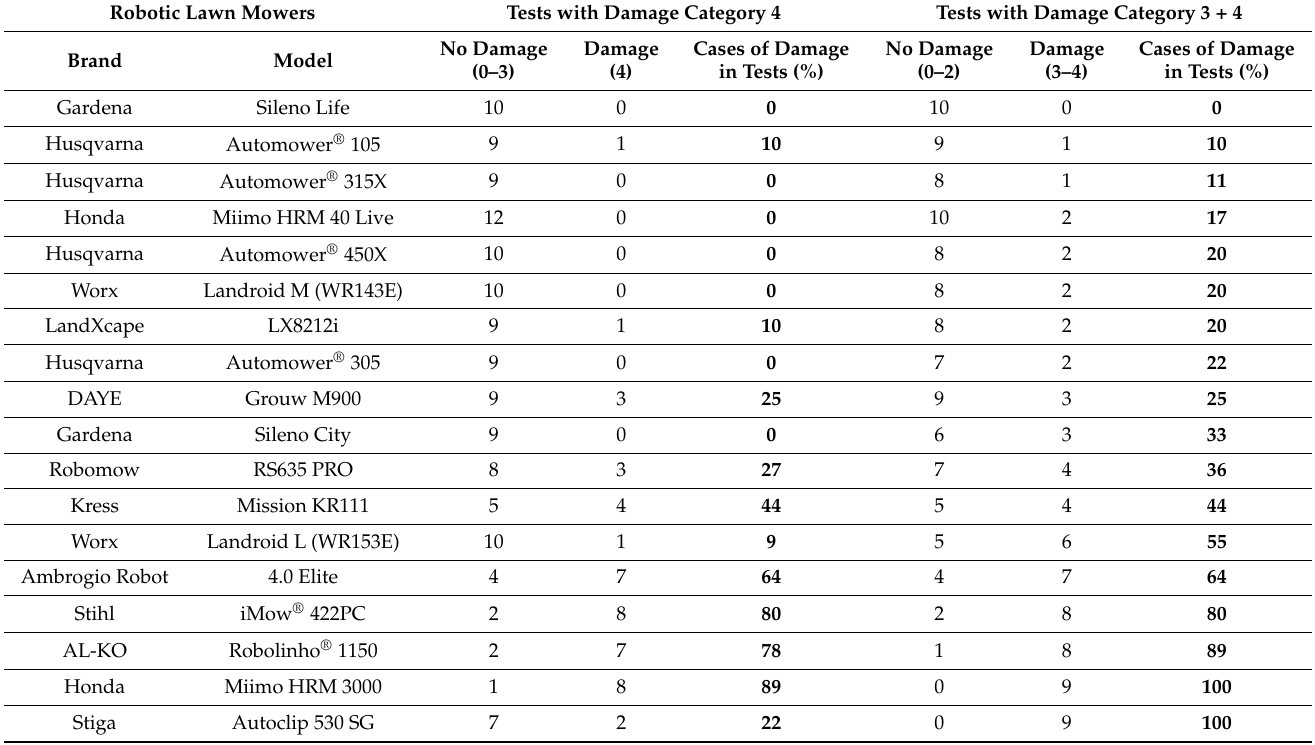
Table 4. The percentage distribution of tests resulting in damage to the hedgehogs, defined either as damage category 4 or damage category 3 + 4. Damage category A was omitted from the analyses, leaving the total number of tests between 9 and 12 depending on the amount of damage category A results recorded per robotic lawn mower. The lower percentage of cases of damage during the tests, the safer the robotic lawn mower. The robotic lawn mower models have been listed in accordance with the percentage distribution of damage defined as damage category 3 + 4. Models showing the lowest damage percentage are listed